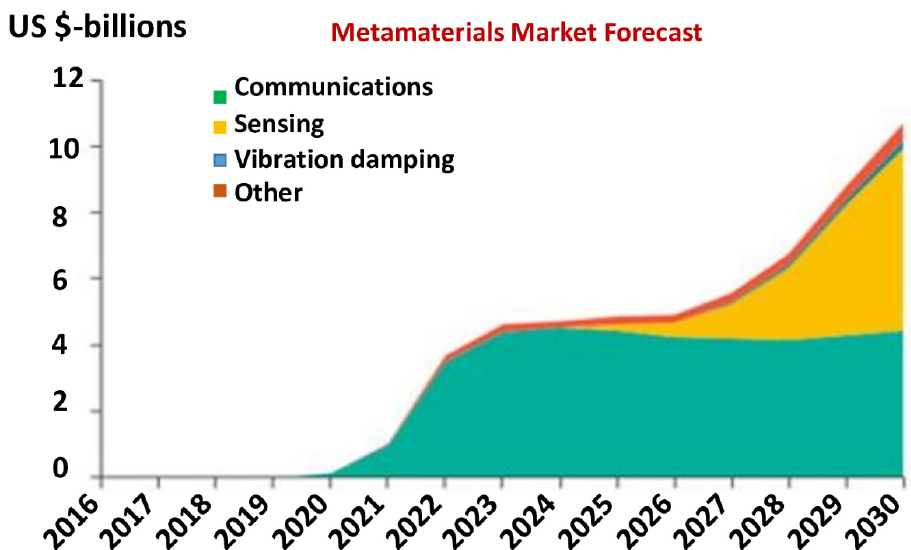
Figure 3. Metamaterials market forecast: metamaterial devices are poised to grow to $10.7 billion by 2030 in 5G networks, autonomous vehicles and connected vehicles. Adapted from Ref. [24].